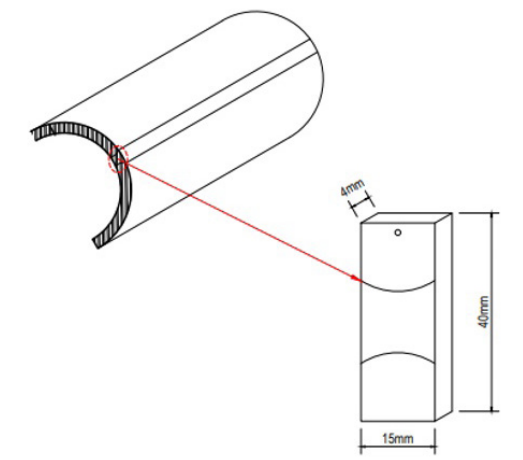
Figure 1. Specimen dimensions in mm. Table 1. Chemical Compositions of the base metal and weld metal in wt%. Base Metal Weld Metal Element (%) wt content (%) wt content